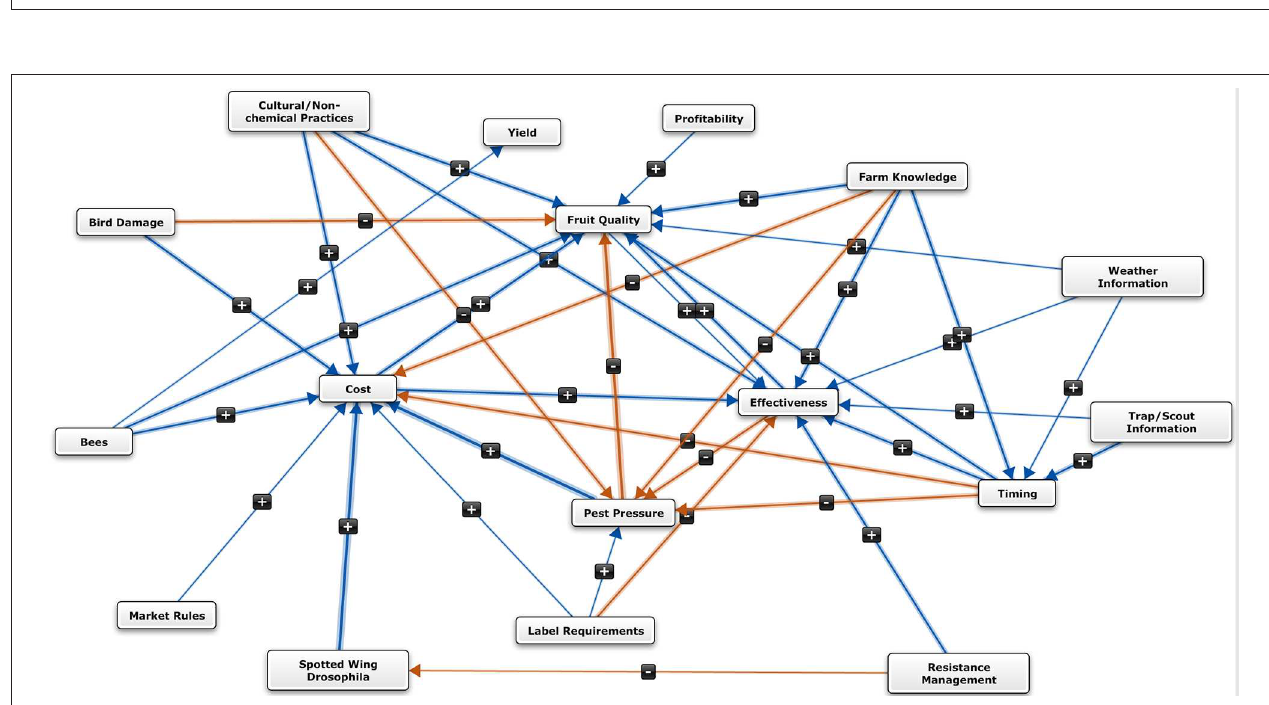
FIGURE 3 | Group map for farmers having neither concept (natural predators, beneficial insects) in their maps . The blue lines indicate a positive relationship (if A increases, so does B) and the red lines indicate a negative relationship (if A increases, B decreases). The thickness of the line indicates the average strength of the relationship for the group of farmers, with thicker lines representing stronger effects, and thin lines representing lighter effects. The arrow indicated the direction of the relationship (A affects B).